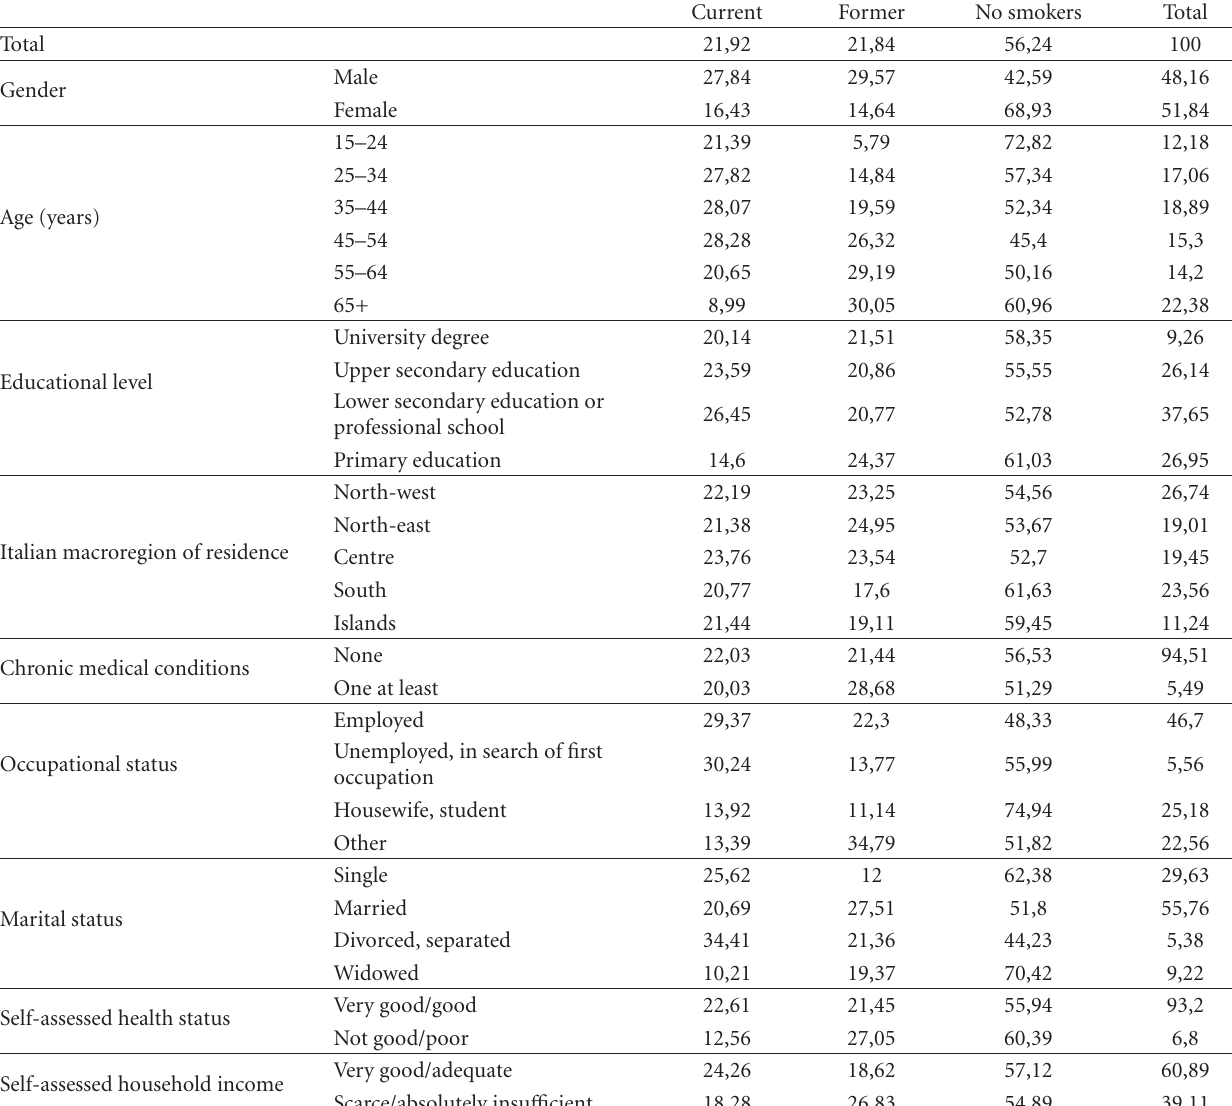
Table 1: Socioeconomic and demographic characteristics of participants, year